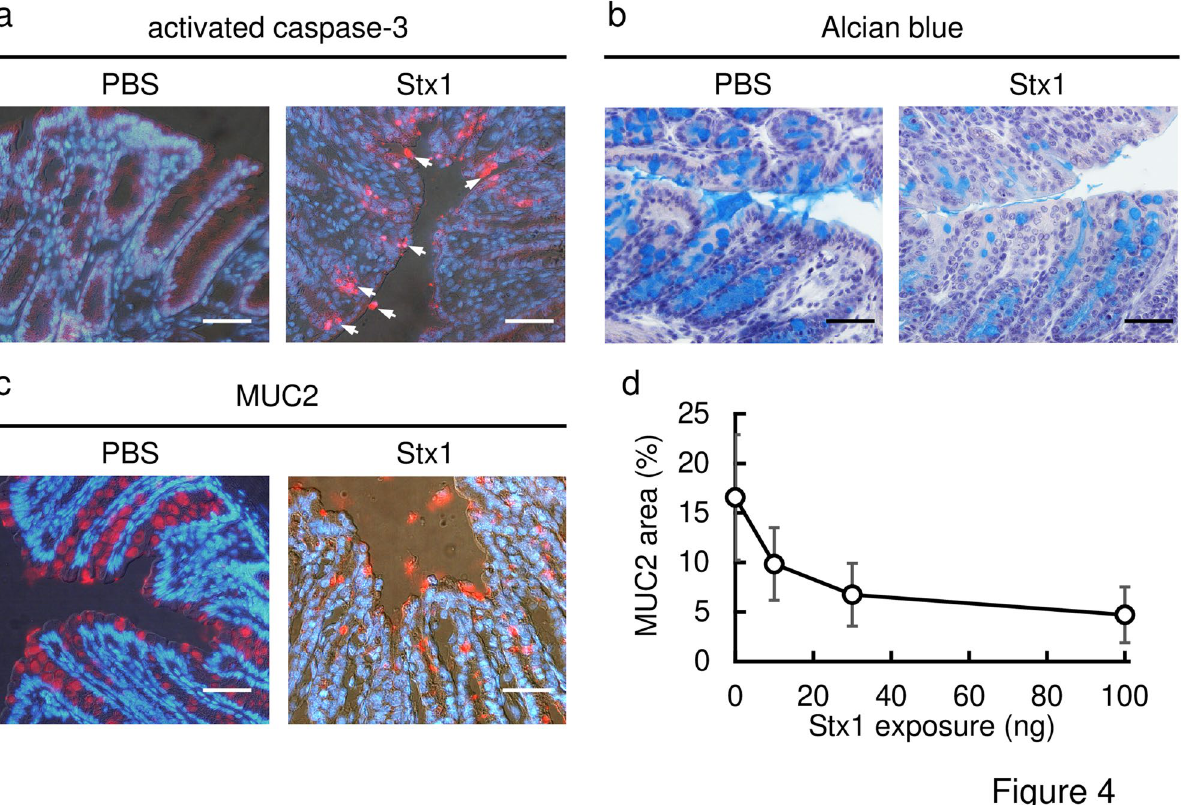
Figure 4. Activation of caspase-3 and depletion of secretory granules in the colon epithelium upon intrarectal exposure to Stx1. Frozen sections ( a,c ) or paraffin sections ( b ) of colon tissue from Stx1-exposed or control (PBS) mice were stained with anti-activated caspase-3 antibodies (red in a ), Alcian blue dye (blue in b ), or anti- MUC2 antibodies (red in c ). Nuclei were visualized by staining with DAPI (blue in a,c ), and with hematoxylin (violet in b ). Arrows indicate signals from activated caspase-3 ( a ). Fixation of tissues was performed with formalin-PBS ( a , c ) or Carnoy’s fixative ( b ). Bars represent 50 μm. Each mouse was exposed to 100 ng of Stx1. ( d ) Quantification of secretory granules in the colon tissues in response to the amount of Stx1 (abscissa) exposed to each mouse. The ordinate indicates the percentage of the MUC2-positive area divided by the total area of the mucous epithelium (mean ± SEM) from four independent mice. There were no exclusions of data